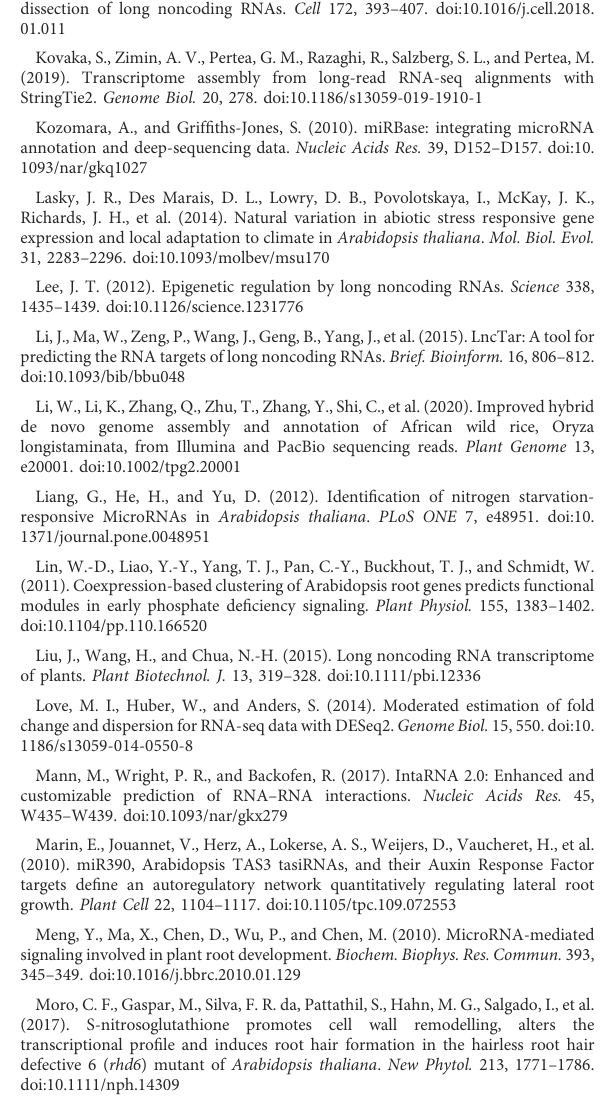
Gene set enrichment analysis (GSEA) results for 1) GSNO-treated/WS- 2 vs. IAA-treated/untreated rhd6 and 2) GSNO/IAA-treated/WS-2 vs. untreated rhd6 groups. The enriched genes are shown and those upregulated for GSNO are highlighted in yellow, whereas those downregulated are highlighted in